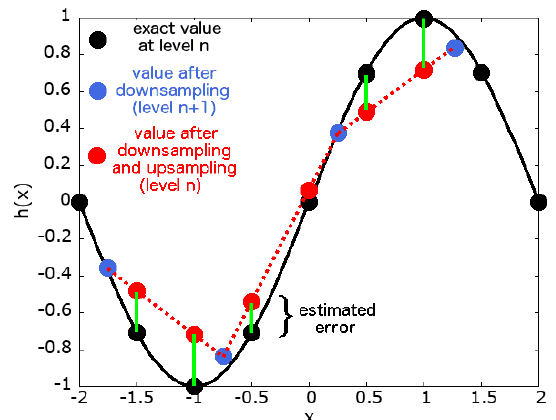
Figure 2. Passing from level n + 1 to level n and estimation of the error (upsampling